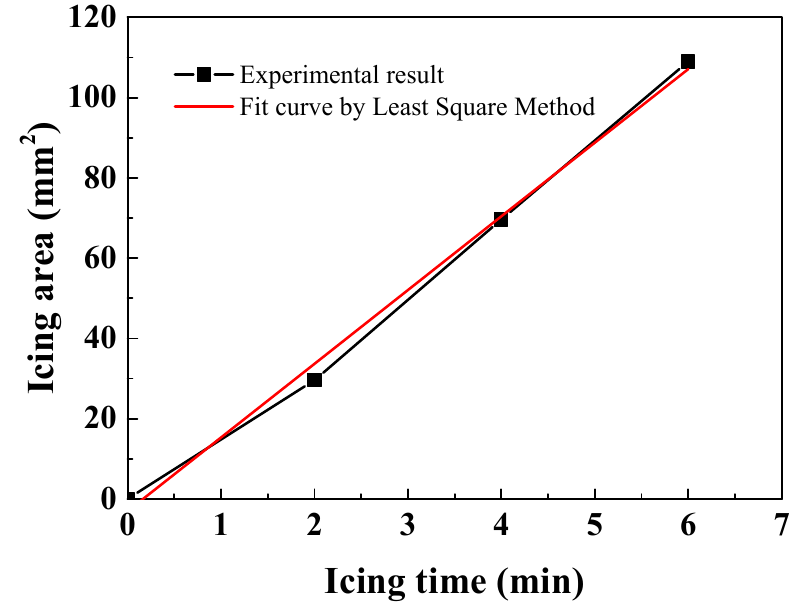
Figure 12. Variation of the icing area with the icing time.